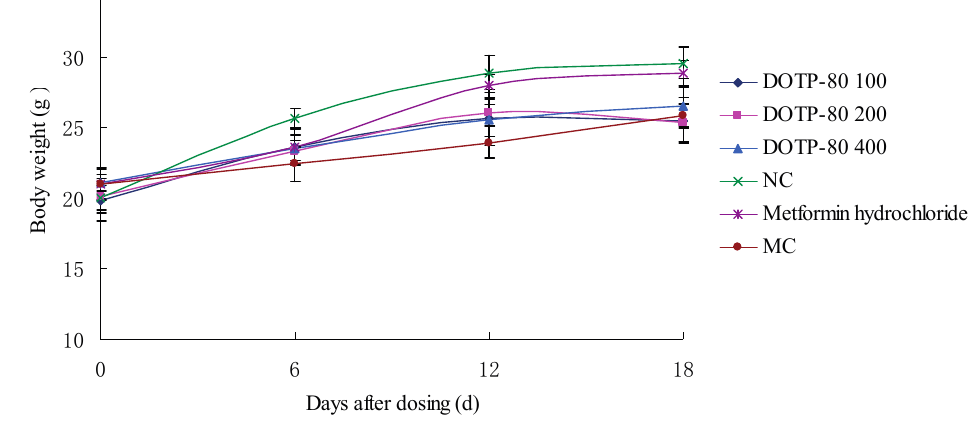
Figure 2. Effect of different doses ( mg/kg body weight ) of DOTP-80 and Metformin hydrochloride on body weight in alloxan-induced diabetic mice. NC: normal control group; MC: model